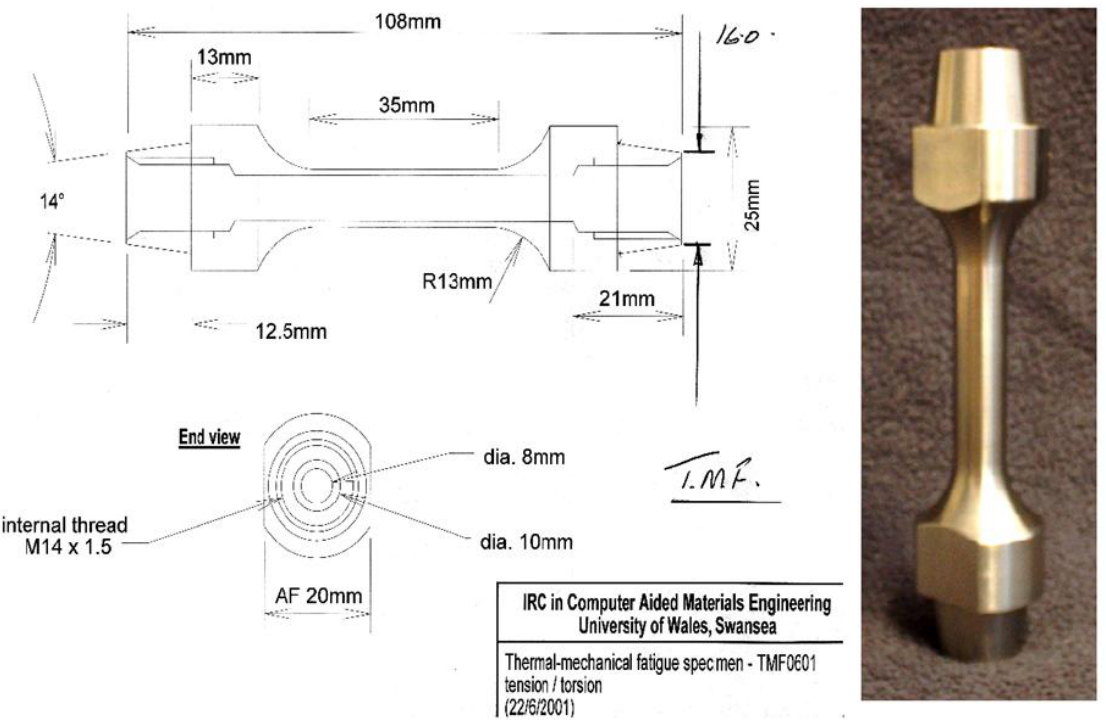
Figure 2. Specimen diagram of test pieces used in this research.